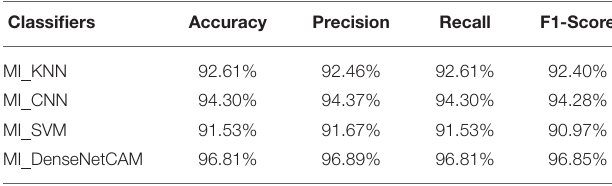
TABLE 5 | The performance evaluation results of four different classifiers.